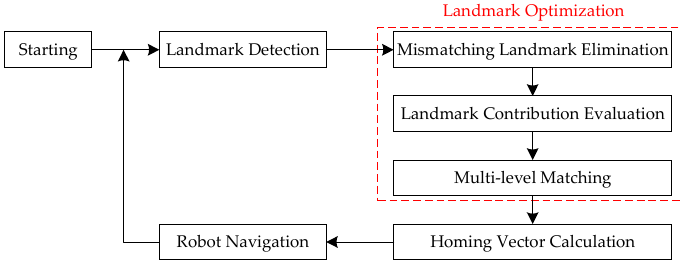
Figure 6. Procedure of the mobile robot’s visual homing process based on the proposed strategies.